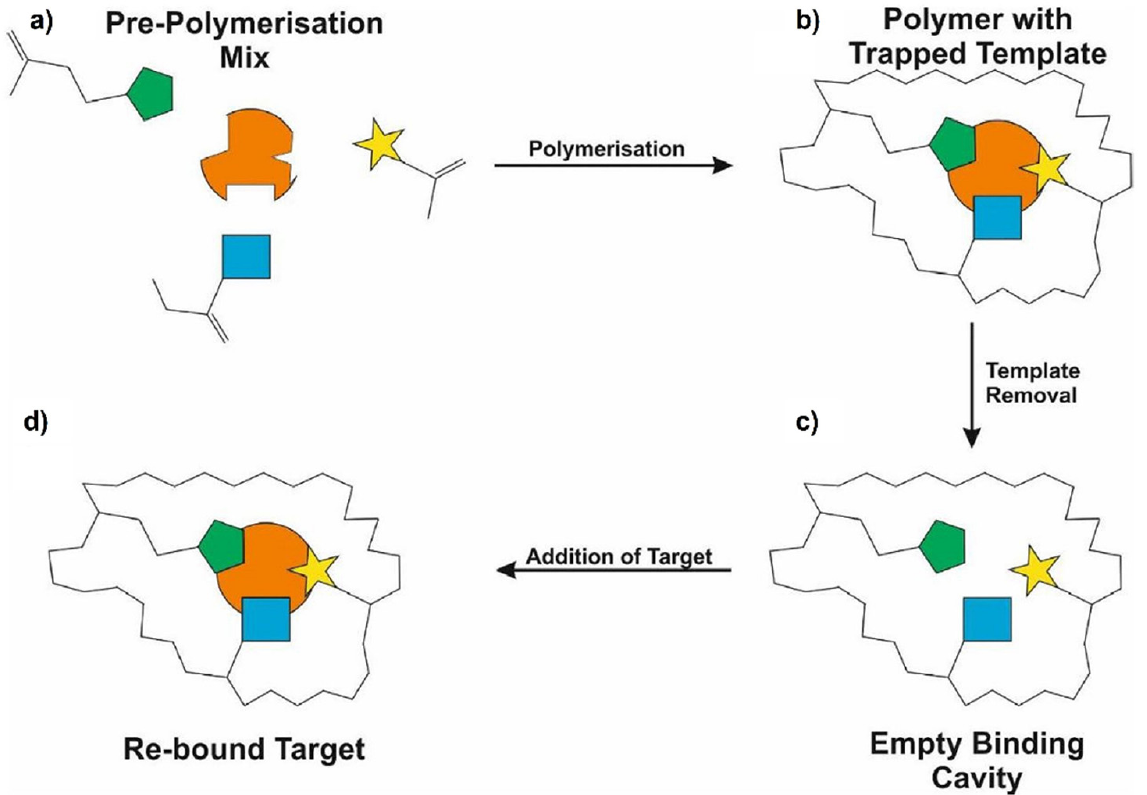
Figure 2. Schematical depiction of the molecular imprinting general idea: ( a ) a pre-polymerization mixture ensures that the non-covalent interactions stabilize between the template and functional monomers, followed by the polymerization; ( b ) the template is entrapped in the polymer matrix; ( c ) after template removal, a molecular cavity of complementary size, shape, and functionality to the target is created inside the polymer; ( d ) when the target is reintroduced, it will bind back inside the cavity [4].